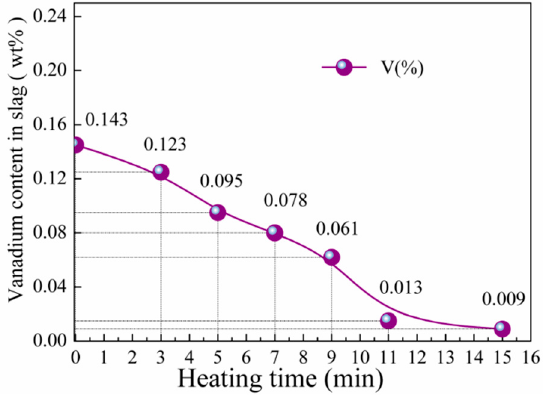
Figure 8. The content of V in slag with different electrode heating time.